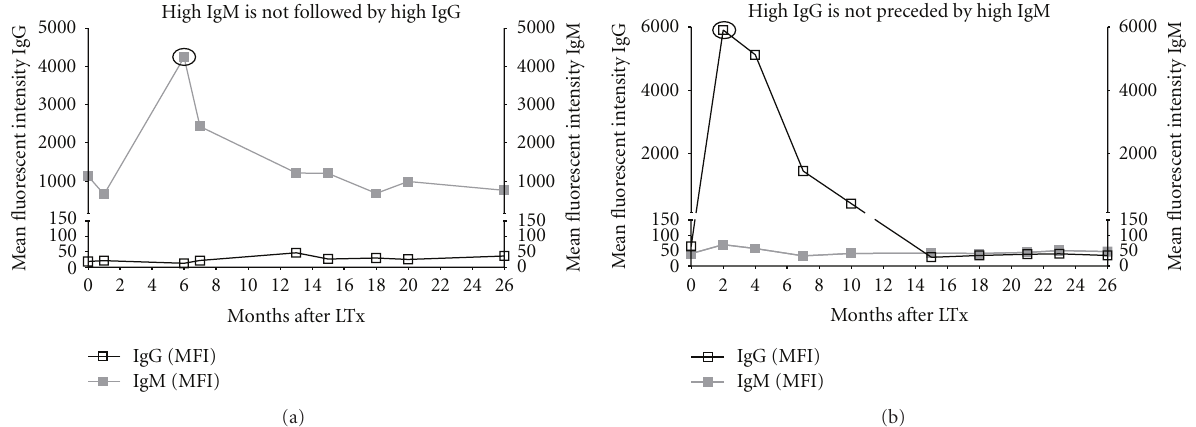
Figure 3: Examples of no correlation between levels of IgM and IgG anti-HLA. Elevated levels of IgM are not followed in time by high levels of IgG levels (a), and increased levels of IgG are not preceded by high levels of IgM (b). Figures are indicative of 1 bead obtained from 1 patient in